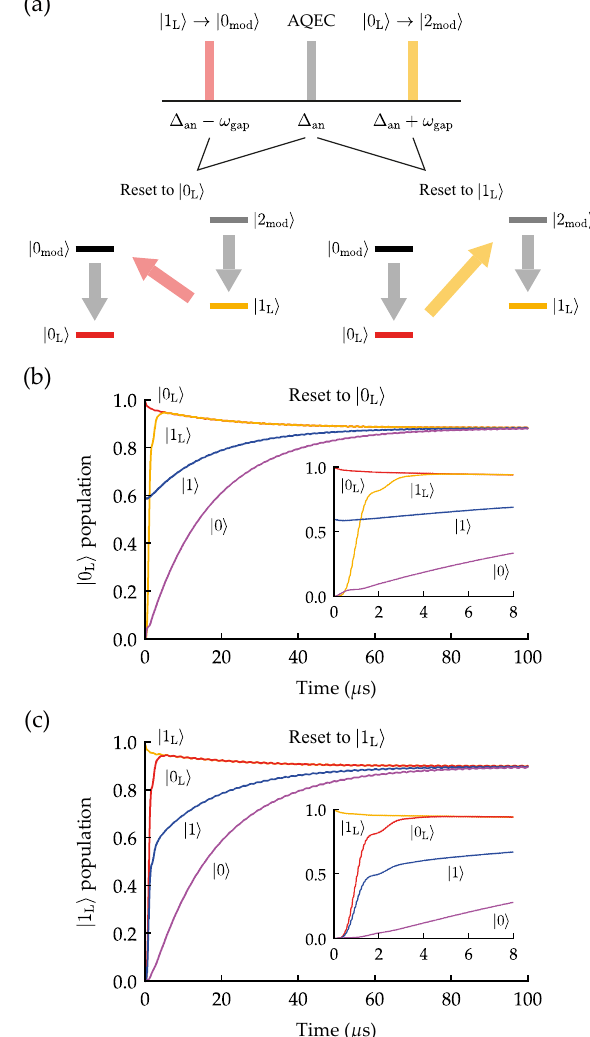
Fig. 5 Unconditional reset. a Frequencies of the reset/correction tones (upper panel) and population transfer path created by these two tones (lower panel). The reset tone in red and the correction tone in gray lock the system state to 0 L j i , whereas the orange and gray lock the system to 1 L j i by following the population transfer path. The frequency of the reset tone is determined by the position of the dip in Fig. 2a. b and c Numerical simulation of our reset scheme. The states near the curves indicate the initial states. The insets show the short-time behavior. The parameters for b are as follows: A cor /2 π = 0.50 MHz, ω reset /2 π = ω cor /2 π − 12.2 MHz, A reset / 2 π = 0.32 MHz. The parameters for c are as follows: A cor /2 π = 0.45 MHz,